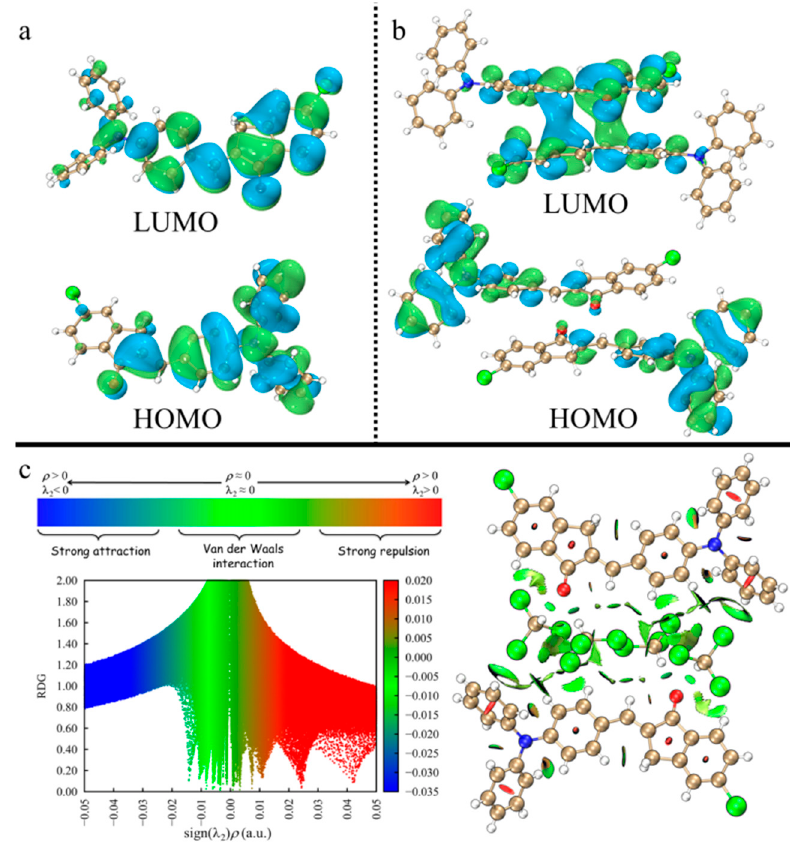
Figure 5. The calculated HOMO and LUMO molecular orbitals of compound 1 in ( a ) monodisperse state and ( b ) “molecular pair” state, the colors of lime and cyan are positive and negative phase; ( c ) The RDG isosurfaces as well as color-filled map of RDG versus the product of second Hessian eigen and electron density for the CHCl 3 -containing